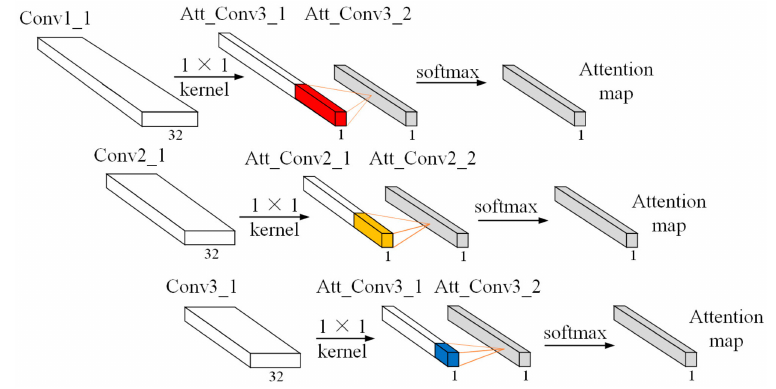
Figure 3. Temporal attention